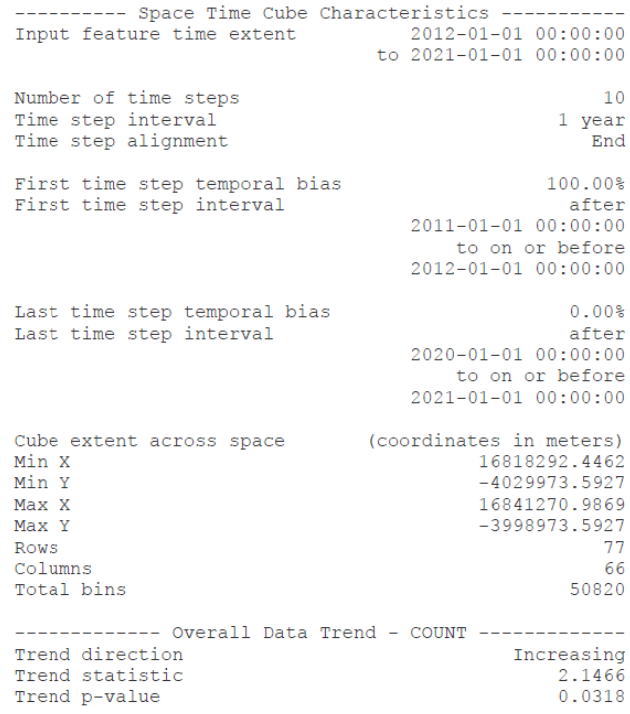
Figure A6. All venues space-time cube logfile.